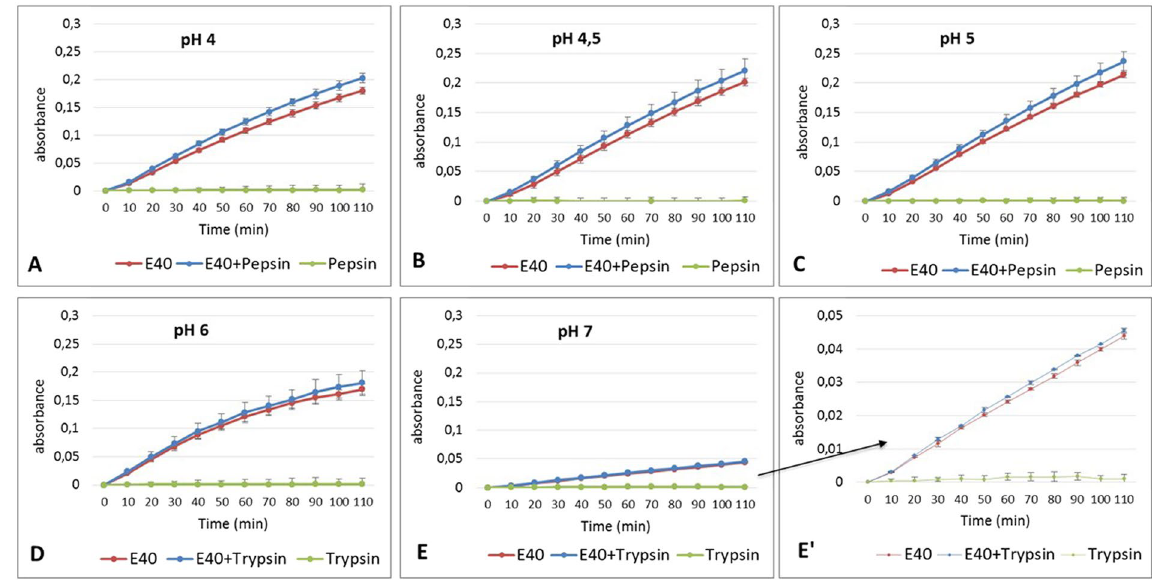
Figure 4. Activity of E40 evaluated in absence or in presence of digestive proteases pepsin (P) or trypsin (T) at pH 4, 4.5 and 5 for P (panels (A–C)) or pH 6 and 7 for T (panels (D and E)), respectively. Enzymes and substrate solutions were separately incubated at 37 °C for 5 minutes, the reactions were started by addition of the substrate to enzyme samples of E40 alone (red line), E40 with P or T (blue line), and P or T alone (green line). Each reaction condition was tested in duplicate; error bars represent the standard deviation. Final concentrations in reaction mix were: 200 µ M substrate, 1–4 nM E40 for incubations at pH 4 to 5 or 4 nM and 7 nM for incubations at pH 6 or 7, respectively (E40 concentration was adjusted according to optimum pH). The digestive protease were maintained in the ratio was 1:2 (w/w) versus E40. Panel (E’) is a magnification of E. X axis: incubation time (minutes), Y axis: absorbance units read at 410 nm. (R 2 values are 0.9948, 0.9976, 0.9978, 0.9639, 0.9994 for E40 alone and 0.993, 0.9975, 0.9982: 0.9661, 0.9994 for E40 + P/T for pH 4, 4.5, 5, 6 and 7,